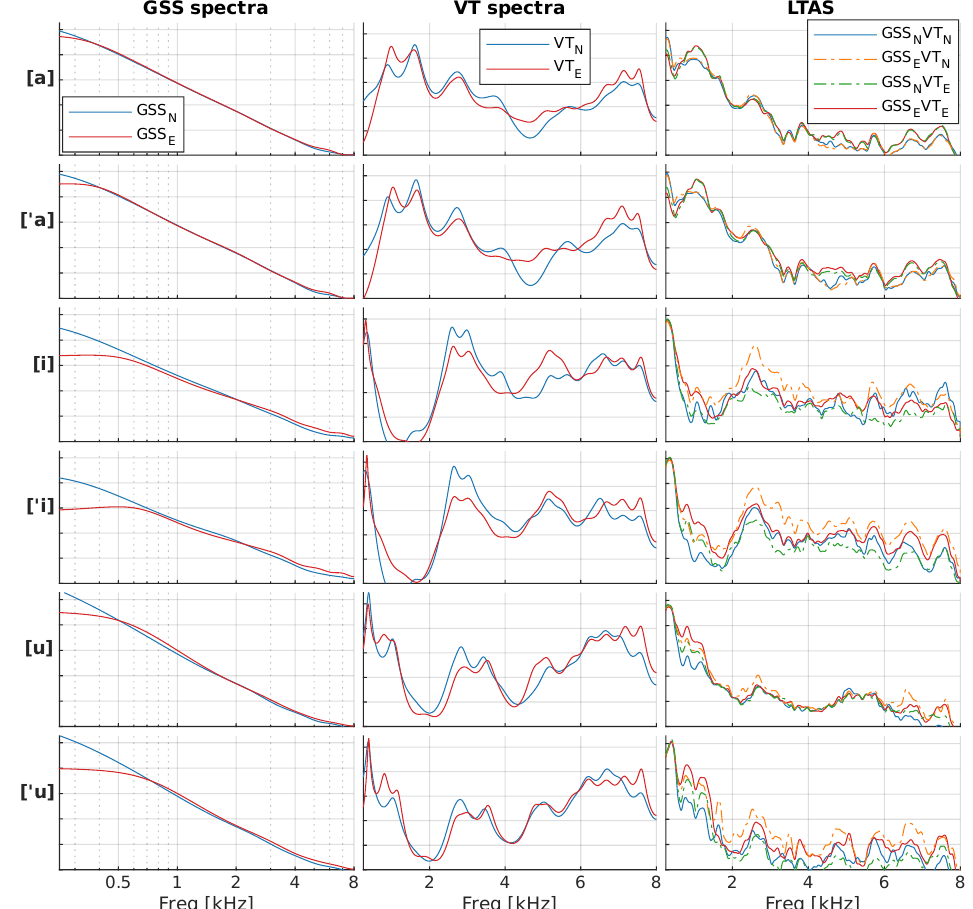
Figure 7. Averaged spectra of the analysed configurations for the aggressive emotion. The first and the second column show the spectra obtained from the mean vectors of glottal source spectra and vocal tract, respectively, for the neutral (GSS N , VT N ) and expressive (GSS E , VT E ) configurations. The third column depicts the mean LTAS of the samples synthesised with the considered combinations of GSS and